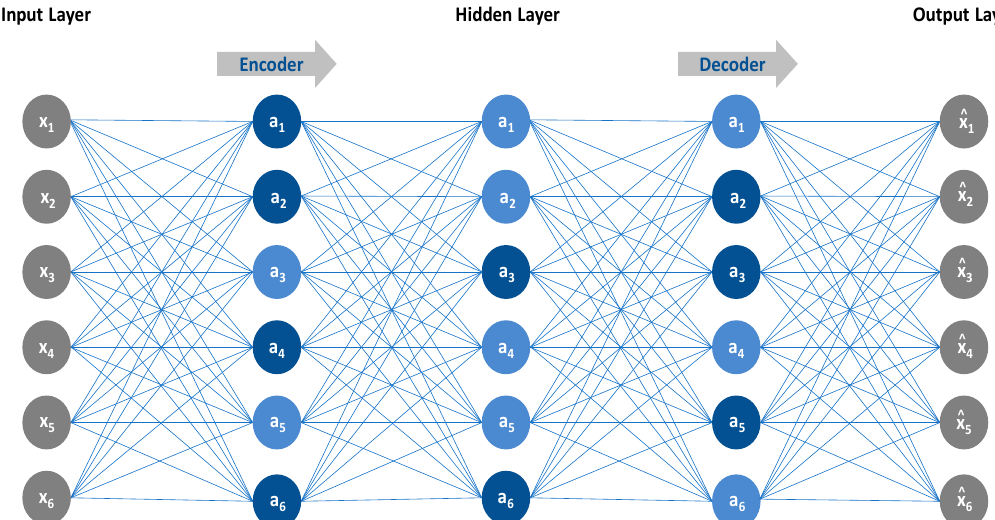
Figure 5. A representation of a sparse autoencoder [46].